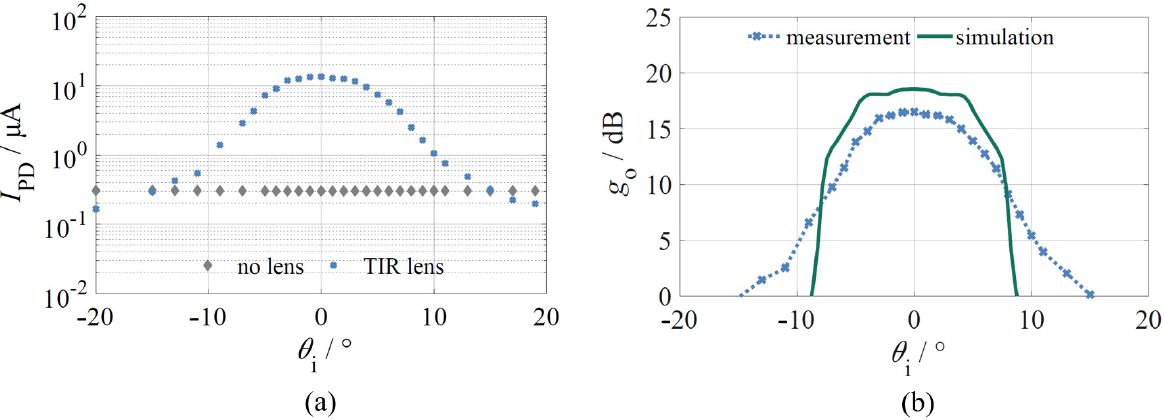
Figure 5. ( a ) Measured photocurrent I PD with and without the TIR lens. ( b ) Measured and simulated concentration ratio g o